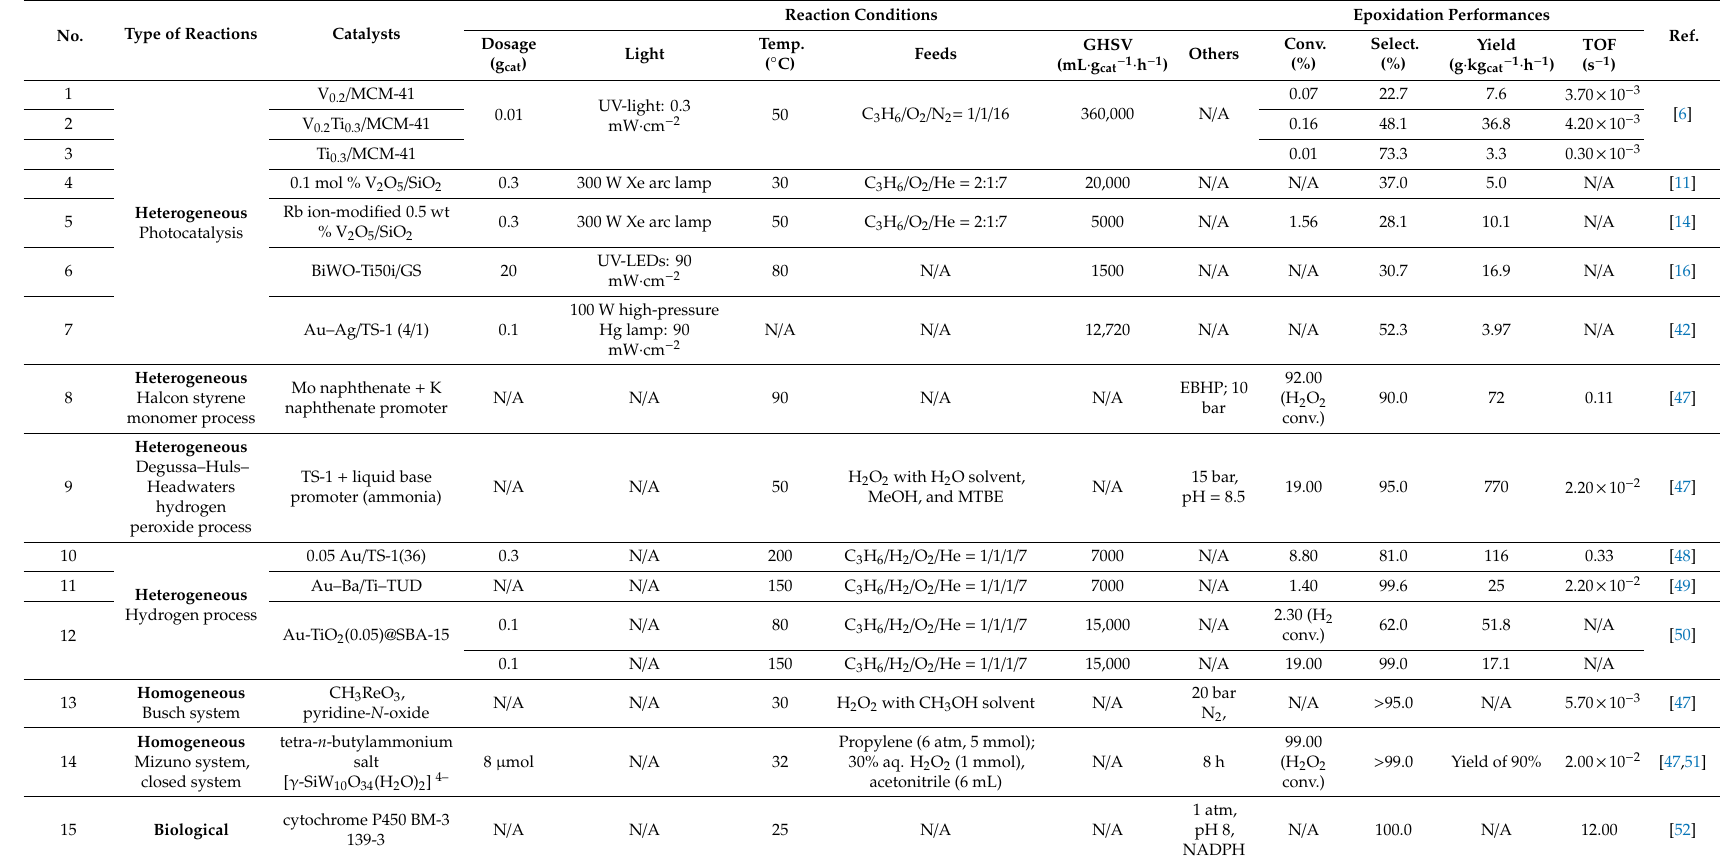
Table 1. Epoxidation of propylene reactions and their